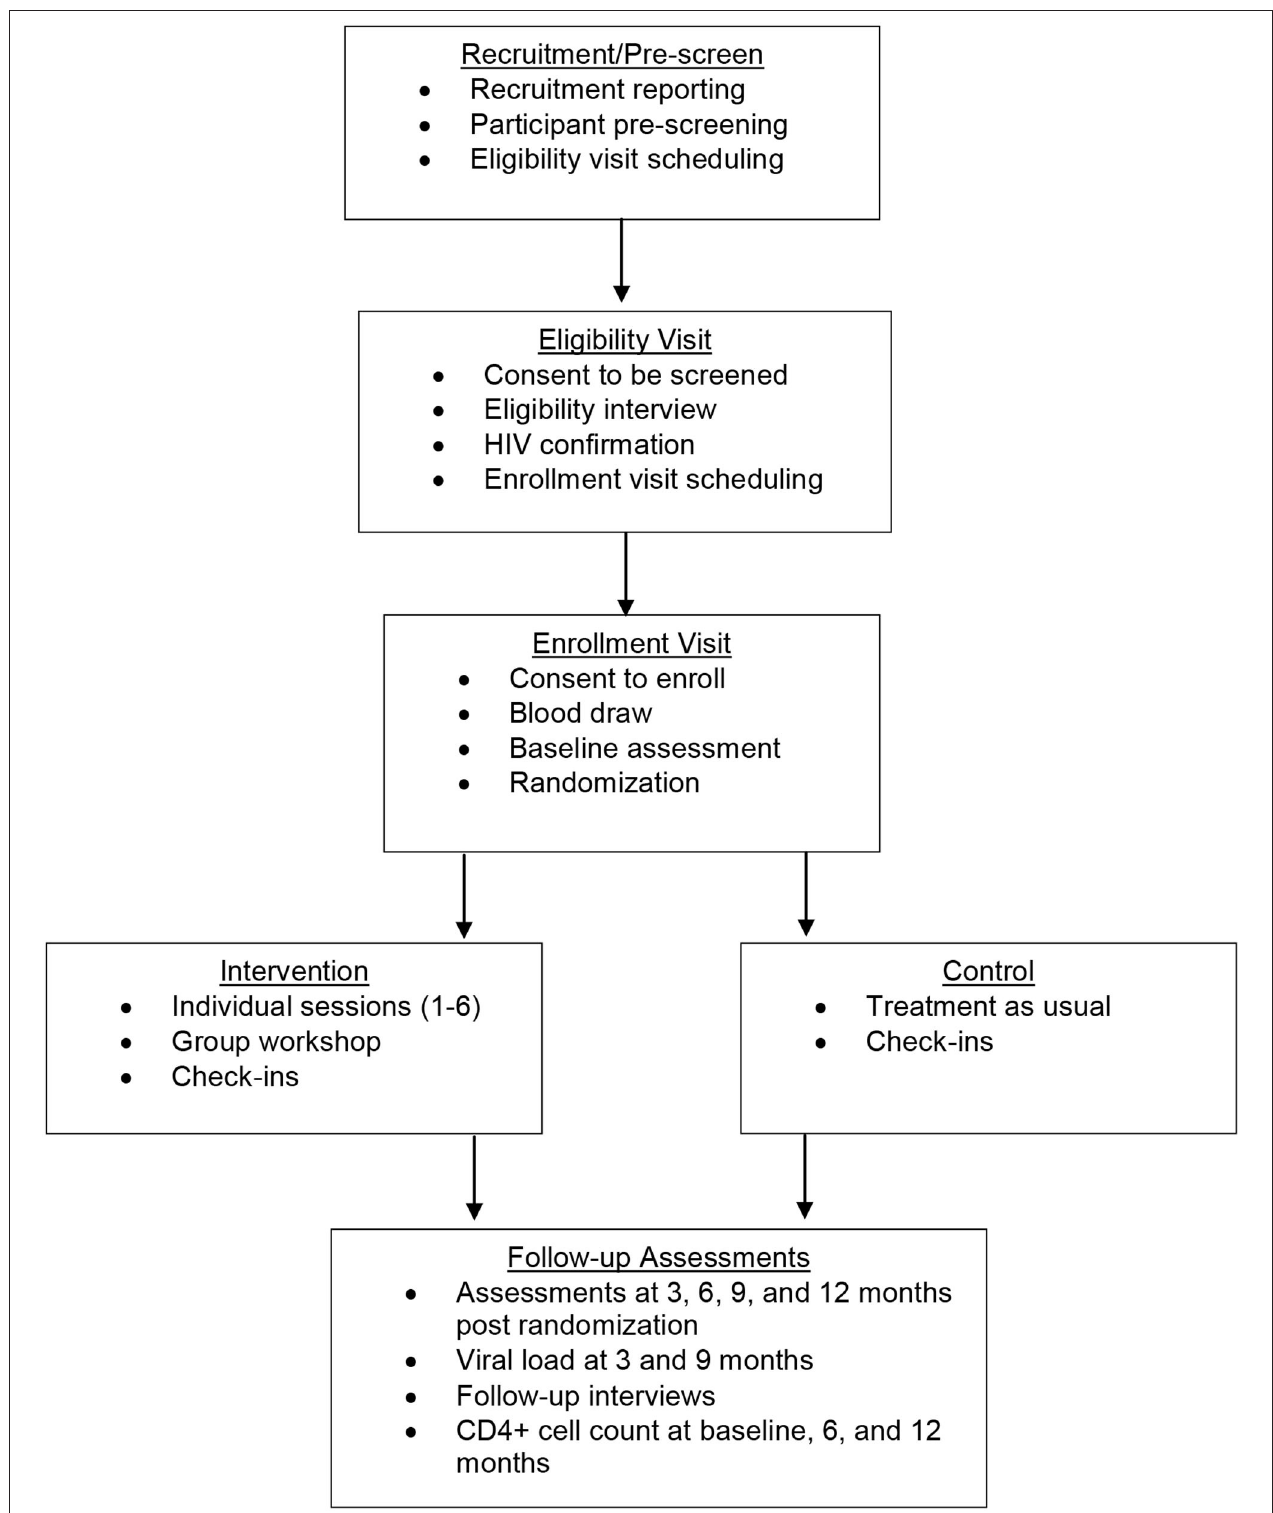
FIGURE 1 | Schedule of enrollment, intervention, and assessments / CONSORT Diagram.